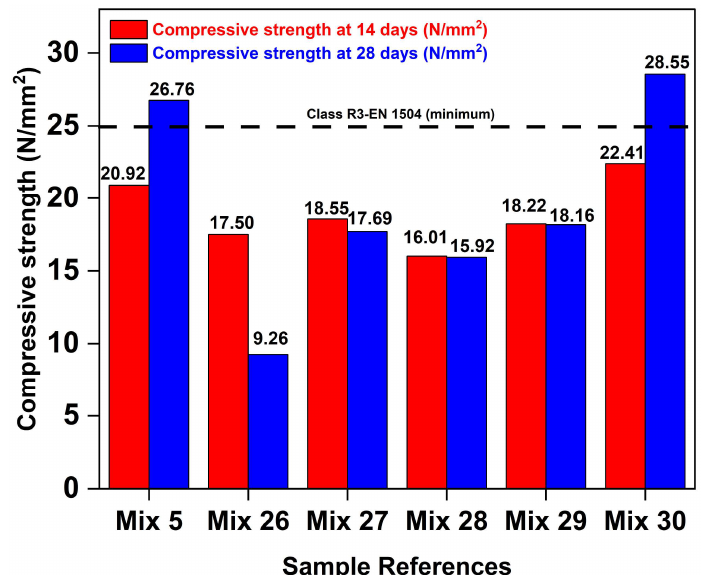
Figure 4. Compressive strength at 14 and 28 days of curing age.